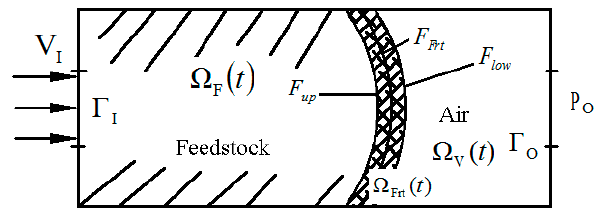
Figure 6. Schematic of the band near the filling front.